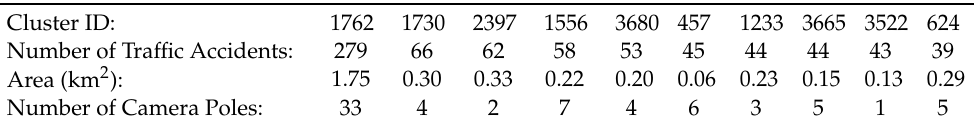
Figure 4. The map representation of the selected clusters (Belgrade, 2021) and camera poles (March 2022). The map was generated using the ArcMap component of the Esri’s ArcGIS suite (https://www.esri.com). Table 2. Description of the selected clusters obtained when the introduced algorithm was applied to publicly available data on traffic accidents with injuries or death that occurred in Belgrade during 2021. The cluster identification numbers given in this table correspond to those given in the legends of Figures 3 and